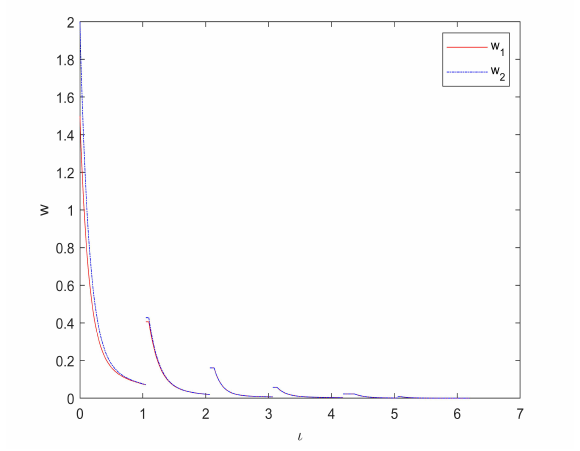
Figure 3. The positive almost periodic solution of model